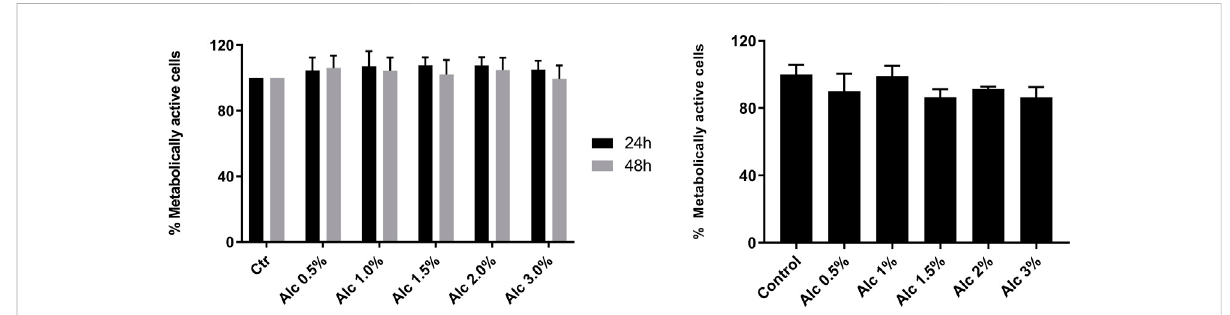
FIGURE 1 Cytotoxic effects induced by ethanol solvent on MDA-MB-231 and HaCaT cell lines. MTT assay was done after two times of incubation, 24 h (blackbars)and48 h(greybars),asfollowing:24and48 h sforMDA-MB-231cells(leftgraph);24 h sforHaCaTcells(rightgraph).Theethanolrange concentrations varied from 0.5 to 3.0% v/v (Alc). Control groups: untreated cells incubated in culture medium for 24 and 48 h s (MDA-MB-231) and for24 h s(HaCaT).Theresultsareexpressedasthemean±standarderrorfromthreeindependentexperiments,doneintriplicate,inrelationto control groups (untreated and treated with